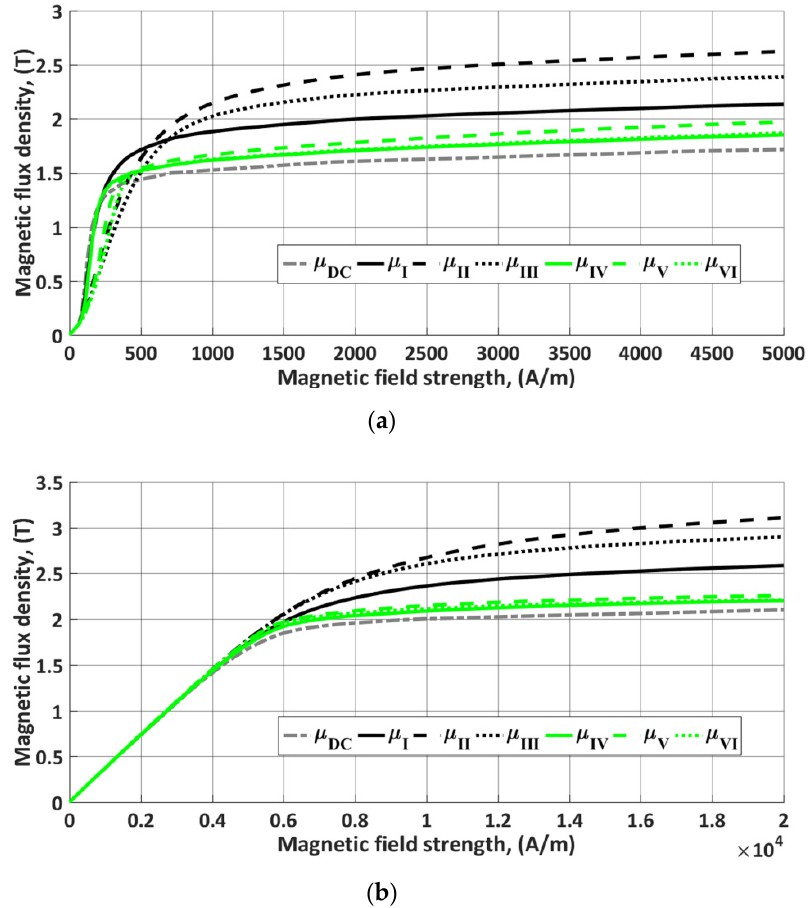
Figure 2. Effective magnetization curves determined from the expressions (1)–(6): ( a ) stator, ( b ) rotor.